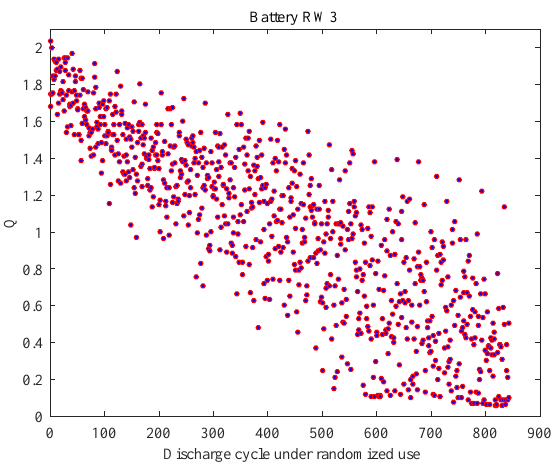
Figure 6. The results of Q k for battery RW3.